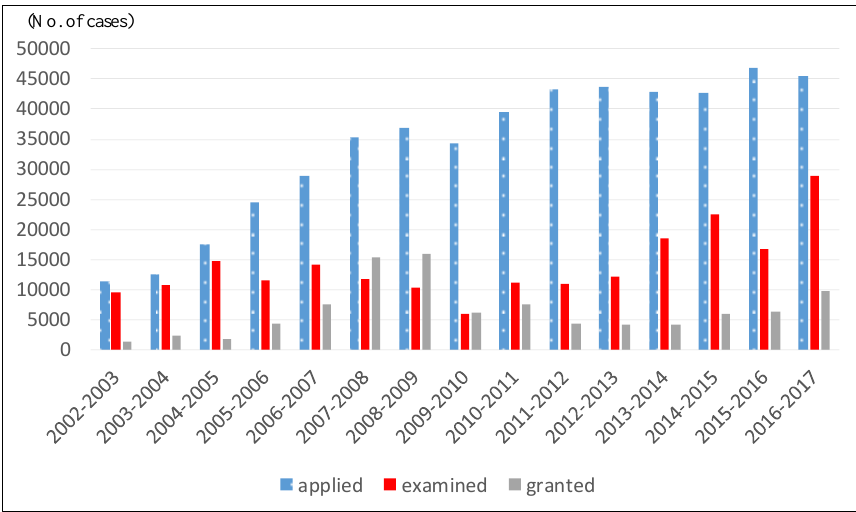
Figure 4. Patent Applied, Examined and Granted in India 2002/03-2016/17; ( IPO Annual Reports 2002/2003- 2016/2017